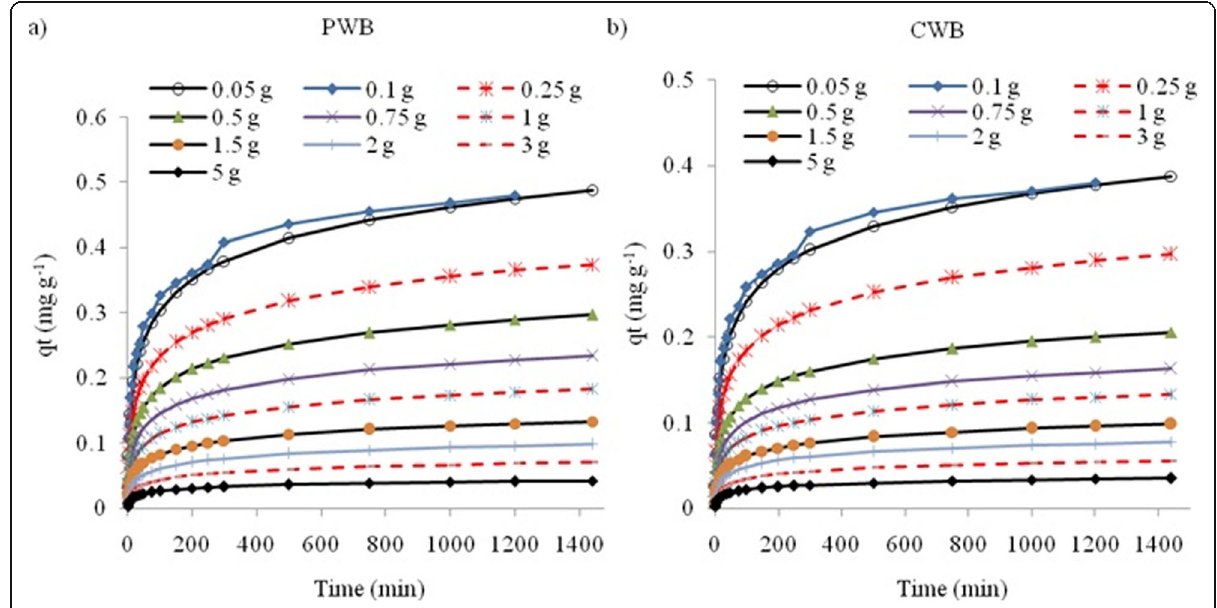
Fig. 3 Determined quantities of adsorption capacity of Pb onto PWB ( a ) and CWB ( b ) using the Elovich kinetic